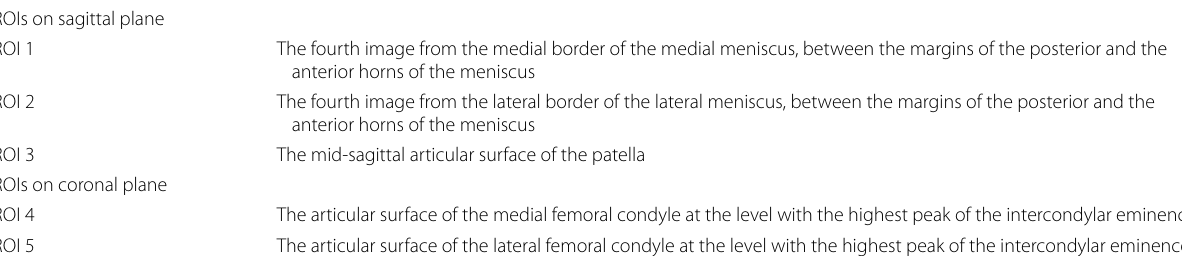
ROI Region of interest